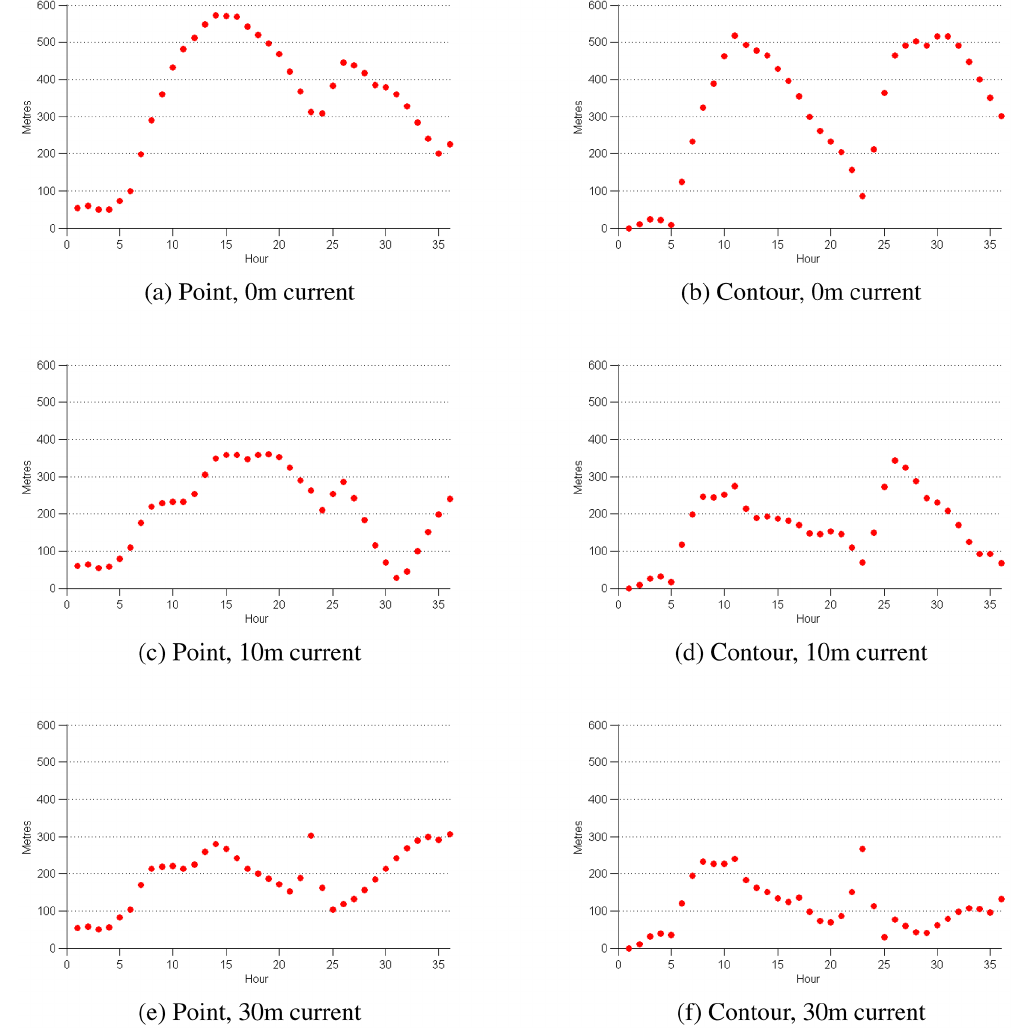
Figure 4. Distance between MEDSLIK and CranSLIK centre of mass forecasts for the Algeria test case (point and contour scenarios), using the current at different depths as the advective